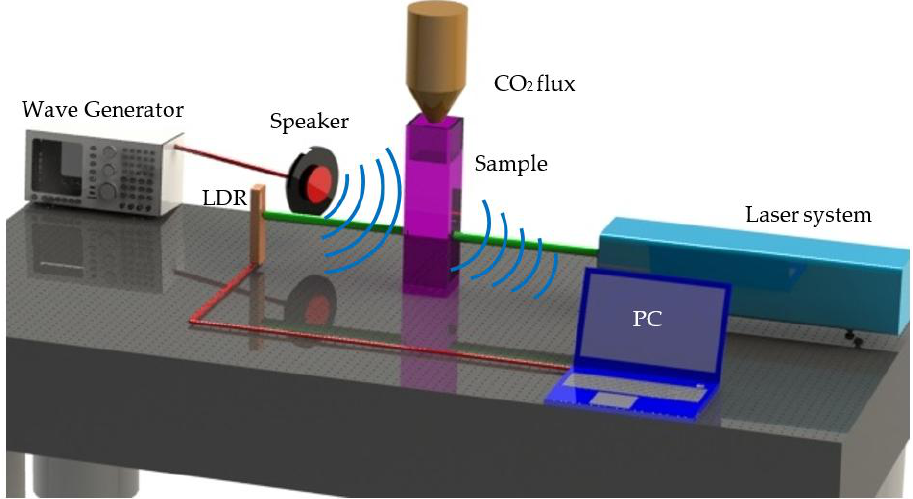
Figure 1. Experimental setup for nonlinear acousto-optical measurements.